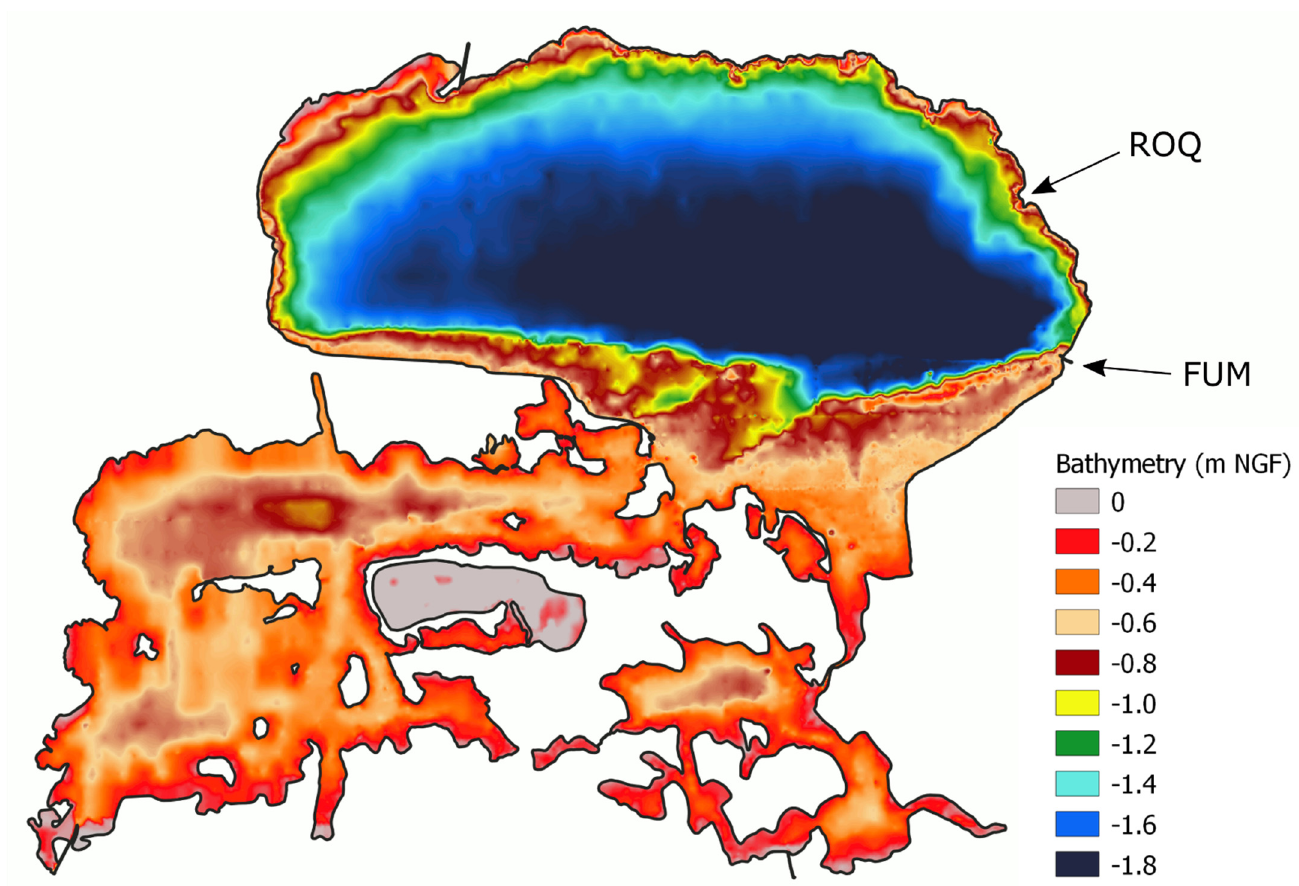
Figure 3. Digital Elevation Model of the Vaccarès Lagoon System generated in this study, with a pixel size of 10 m × 10 m. Total number of pixels: 1,101,438.